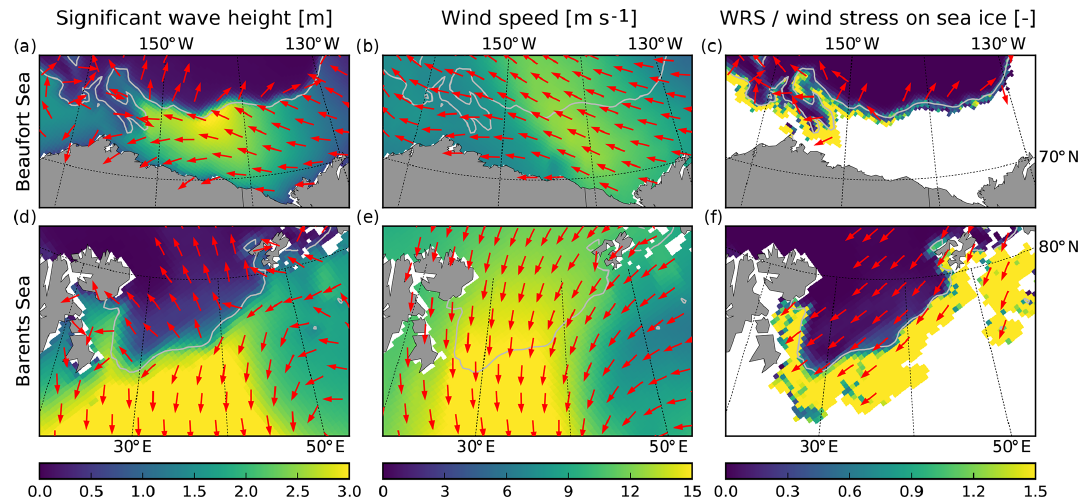
Figure 11. Significant wave height and wave mean direction of propagation (a, d) , wind speed (b, e) and WRS (c, f) simulated by the CPL run during the storms that occurred in the Beaufort Sea (a–c) and in the Barents Sea (d–f) on 16–17 August 2010. The grey contours indicate the position of the sea ice edge determined from the averaged sea ice concentration ( c = 0 .